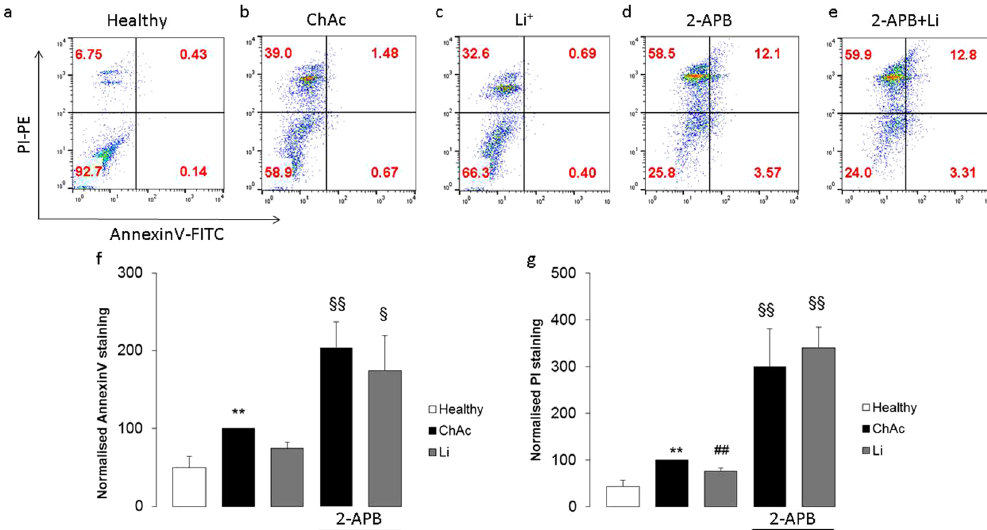
Figure 5. Phosphatidylserine translocation and propidium iodide uptake in neurons from healthy volunteers and from ChAc patients without and with treatment with lithium and/or 2-APB. ( a – e ) Representative dot blots of propidium iodide staining versus annexin-V-binding of neurons generated from ( a ) healthy volunteers and from ( b – e ) ChAc patients ( b ) without treatment and with lithium treatment (2 mM) alone ( c ), with 50 µ M 2-APB alone ( d ), and with lithium and 2-APB together ( e ). (f , g ) Arithmetic means ( ± SEM, n = 4–8 from 4 individuals) of the normalised ( f ) annexin-V-binding or ( g ) propidium iodide stained neurons from healthy volunteers (white bars) and from ChAc patients without (black bars) or with (grey bars) 2 mM lithium treatment without (left bars) and with (right bars) presence of 50 µ M 2-APB (2-APB). ** (p < 0.01) indicates statistically significant difference to respective value in neurons from healthy volunteers, ## (p < 0.01) indicates statistically significant difference to respective value in absence of lithium, § (p < 0.05), §§ (p < 0.01) indicates statistically significant difference to respective value in absence of 2-APB